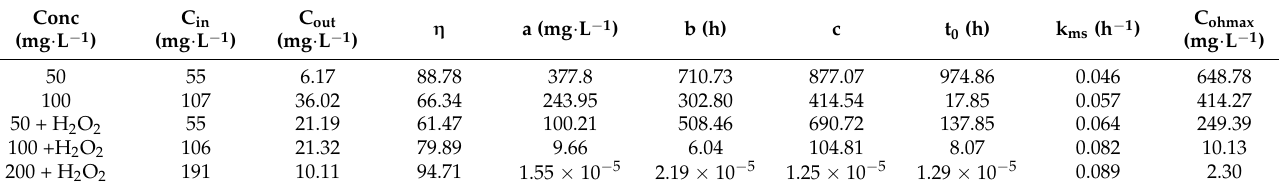
Table 1. The operating conditions for the chemical